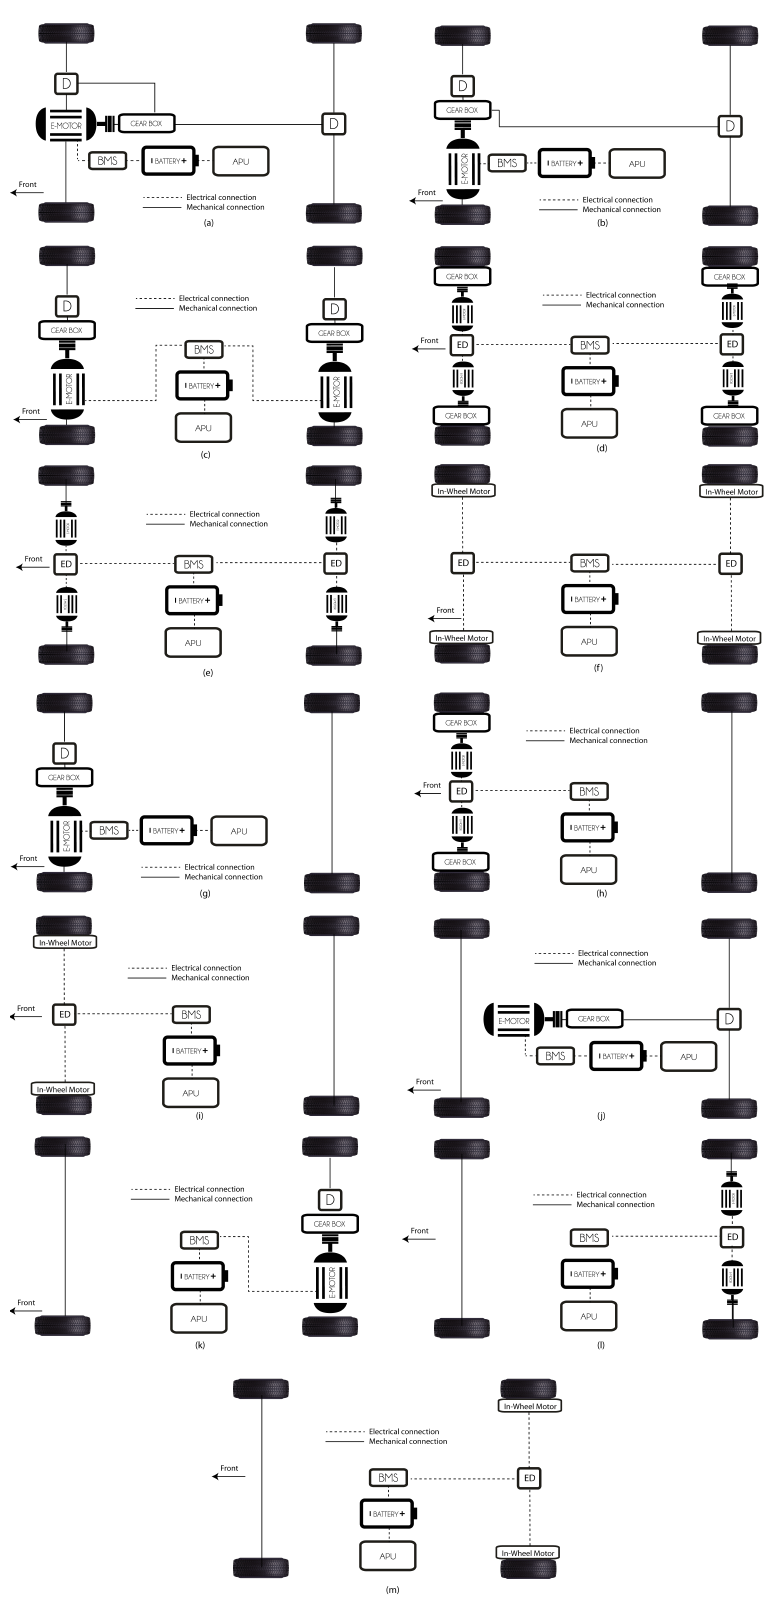
Figure 12. All possible EREV configurations. (3) Rear-wheel drive (RWD) maintains a longitudinal electric motor in Figure 12j, but the rear wheels receive the mechanical power. In Figure 12k, the significant